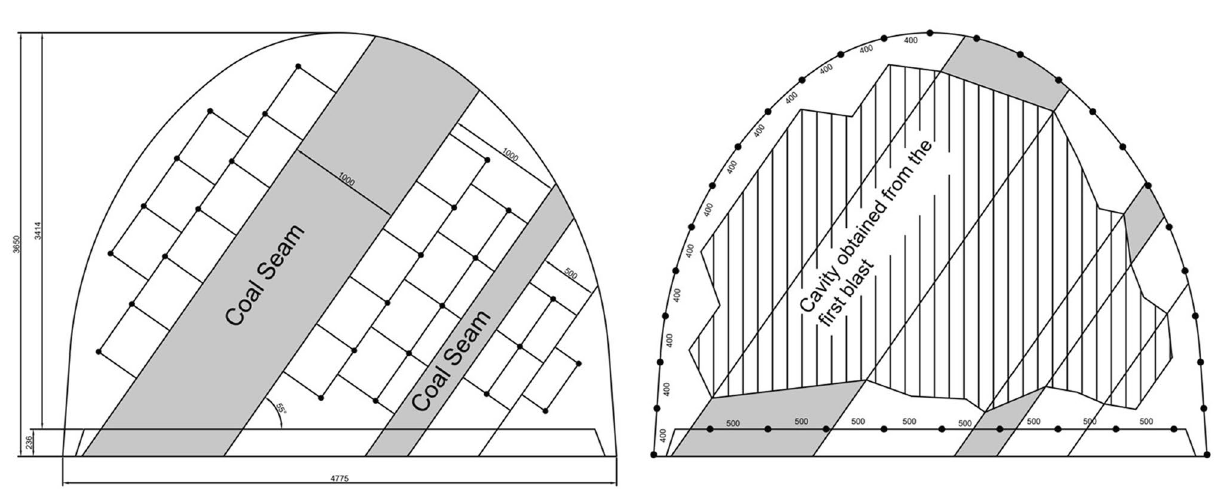
Figure 17. Chosen gateroad geometry and placement of the first and second blast